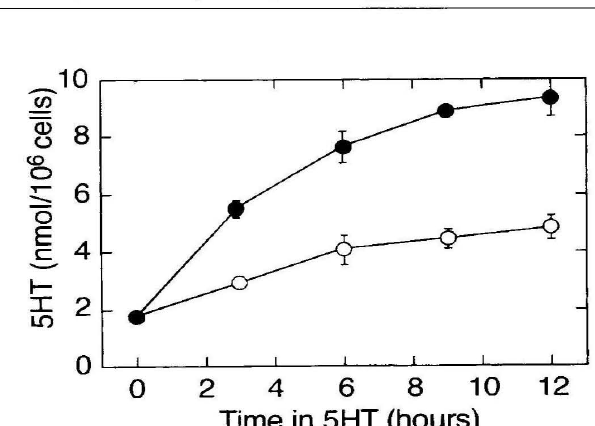
Figure 1. Serotonin loading of RBL2H3 cells: The cells plated one day before the experiment at 1.0 x 10'